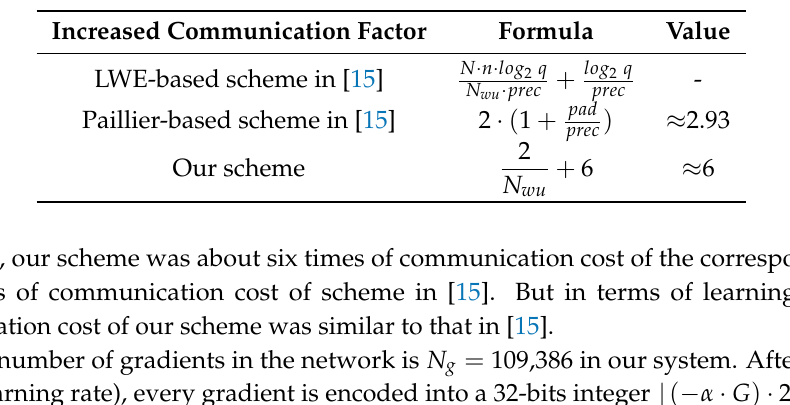
Table 2. Communication cost